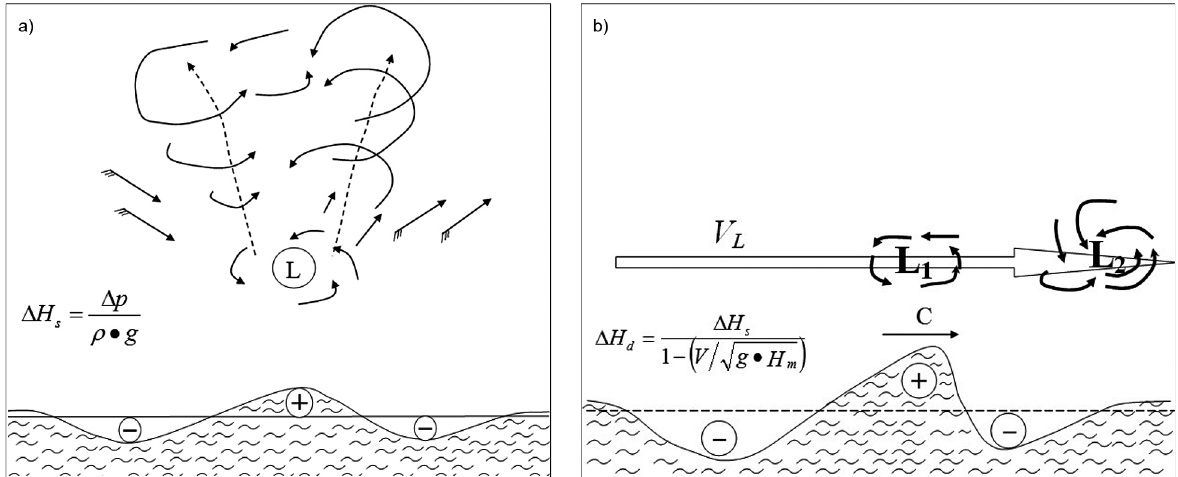
Fig. 12. Diagram of sea surface deformation caused by a low pressure system a) static sea surface deformation, b) dynamic sea surface deformation (Wiśniewski, Wolski